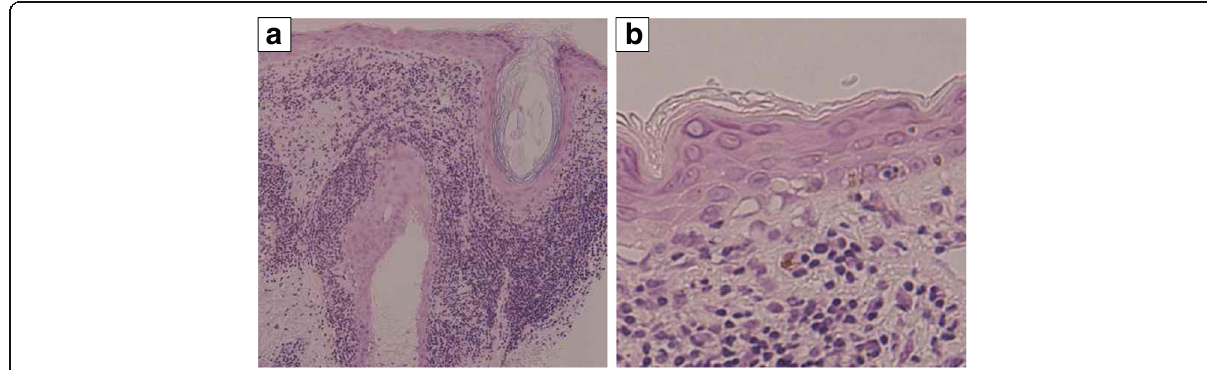
Fig. 5 Pathological findings in an erythematous eruption on the right cheek. a Infiltration of inflammatory cells was seen around the skin appendages (HE, ×100). b Liquefaction degeneration of the basement cells and epidermal atrophy were seen (HE,